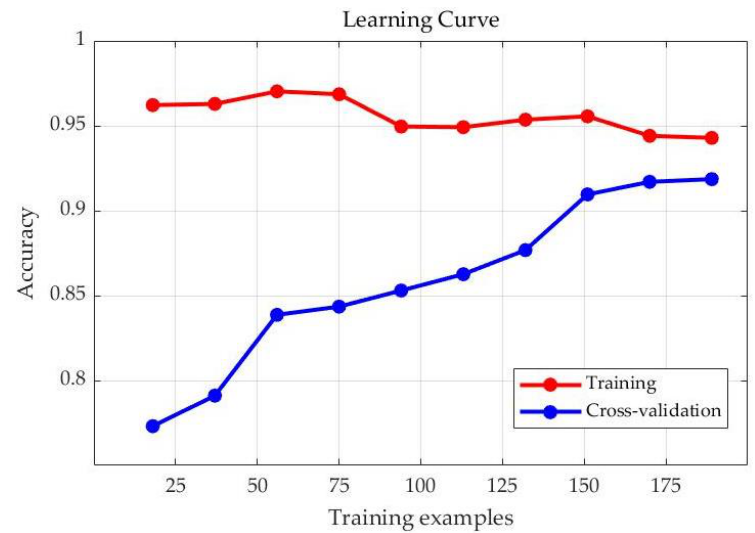
Figure 10. PSO-SVM model learning curve.